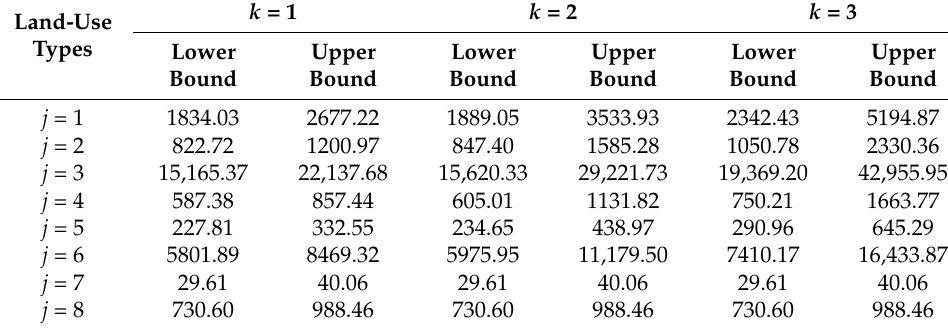
Table A3. Land suitability assessment parameters (km 2 ).